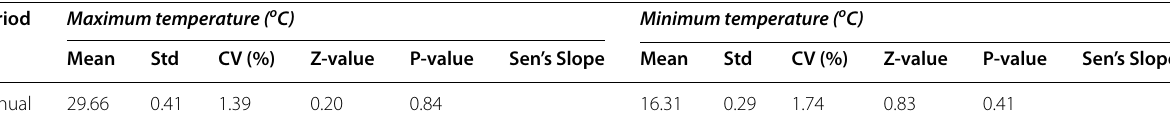
Table 6 Annual mean maximum and minimum temperature (1981–2018) Period